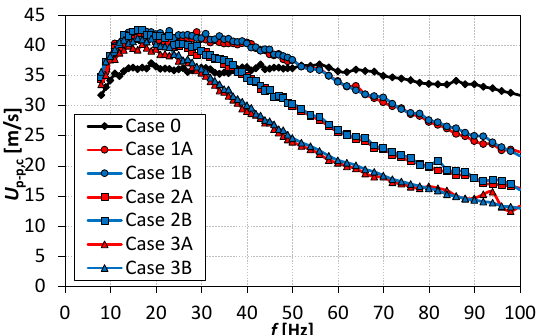
Figure 3. The peak-to-peak, centerline velocity as a function of frequency at p = 3 W, x = 0. In a long orifice, the jet flowing out of the chamber has enough distance and time to stabilize its parameters, e.g., develop a velocity profile. In the case of a short orifice, the jet does not have enough distance and time to fully develop, and its parameters will